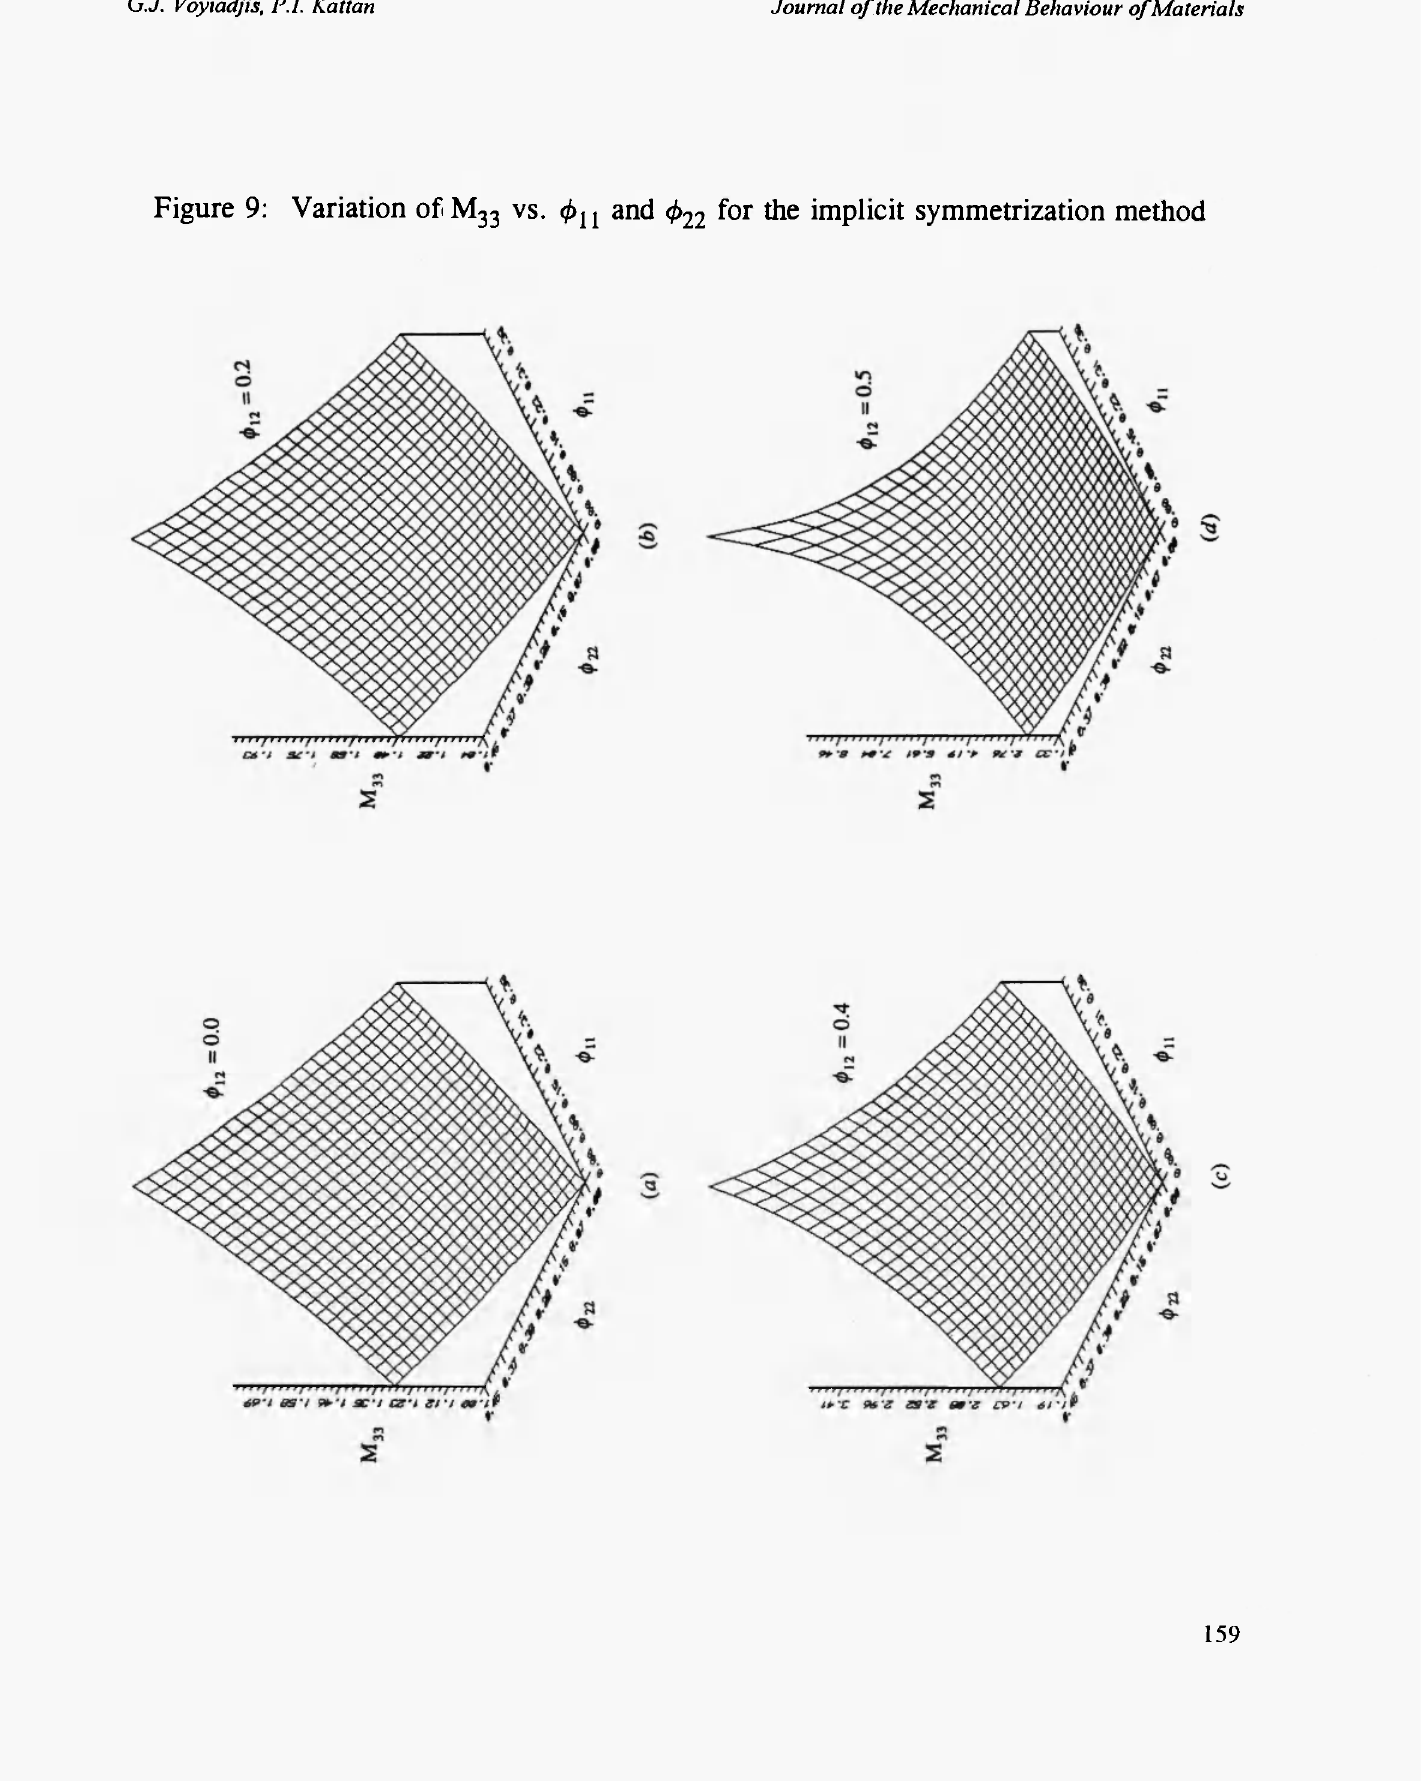
vs. φ and φ for the implicit symmetrization 33 η 22